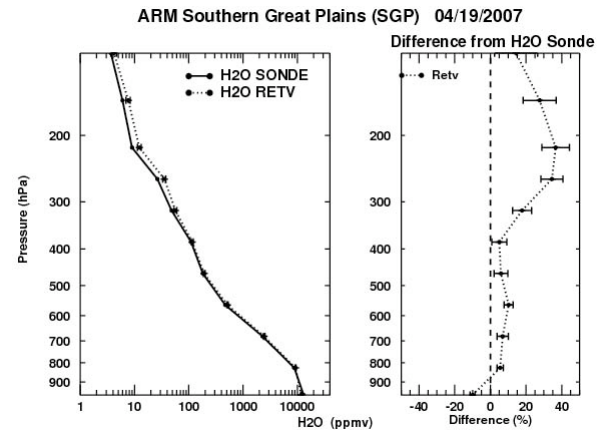
Fig. 8. Comparison plot of the sonde (a priori) and the retrieved water vapor profiles for the ocean case over the Gulf of Mexico.